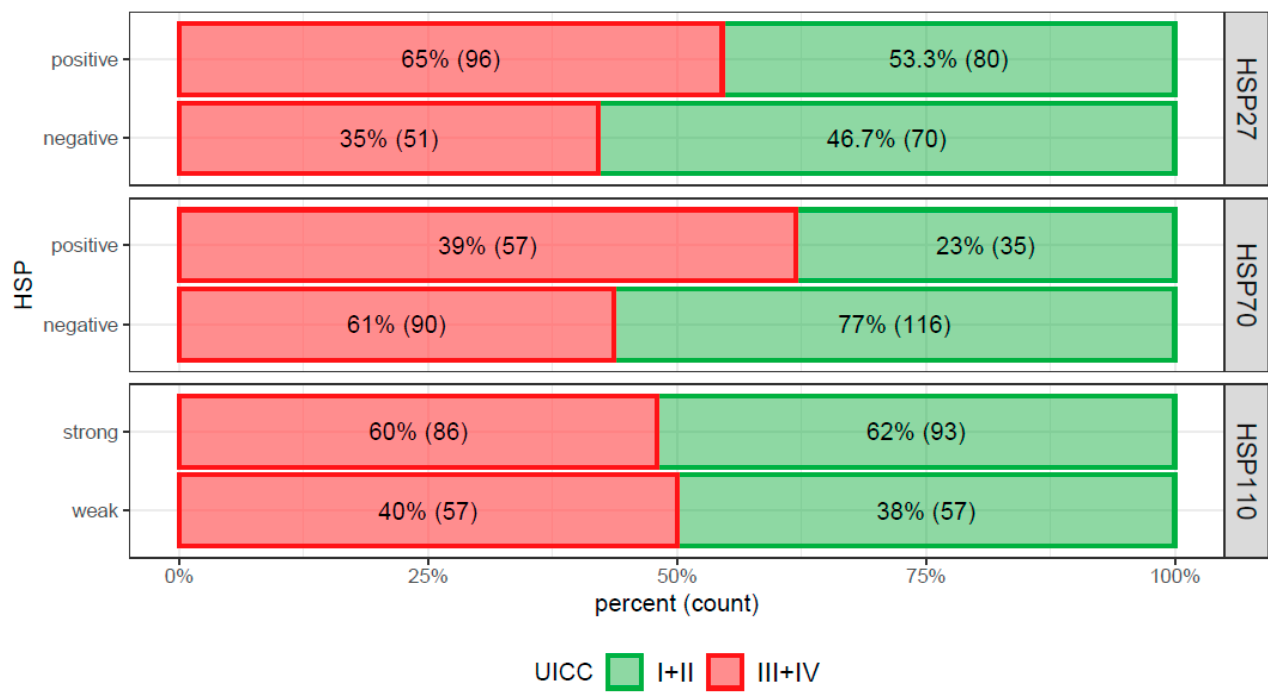
Figure 3. Kaplan–Meier curve documenting cancer specific survival (CSS) in relation to heat shock protein (HSP) status, both HSP27 and HSP70 displayed adverse effect on survival, but was insignificant.